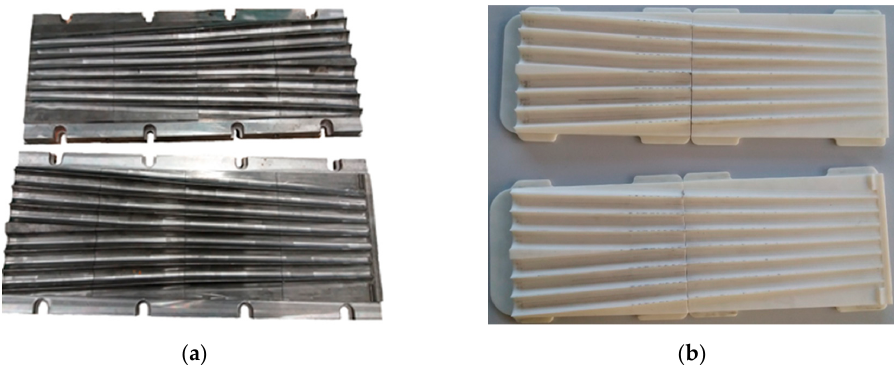
Figure 5. Flat tools for forming of six balls: ( a ) 40 mm diameter steel balls; ( b ) 1:2.5 scale model tools for plasticine balls.